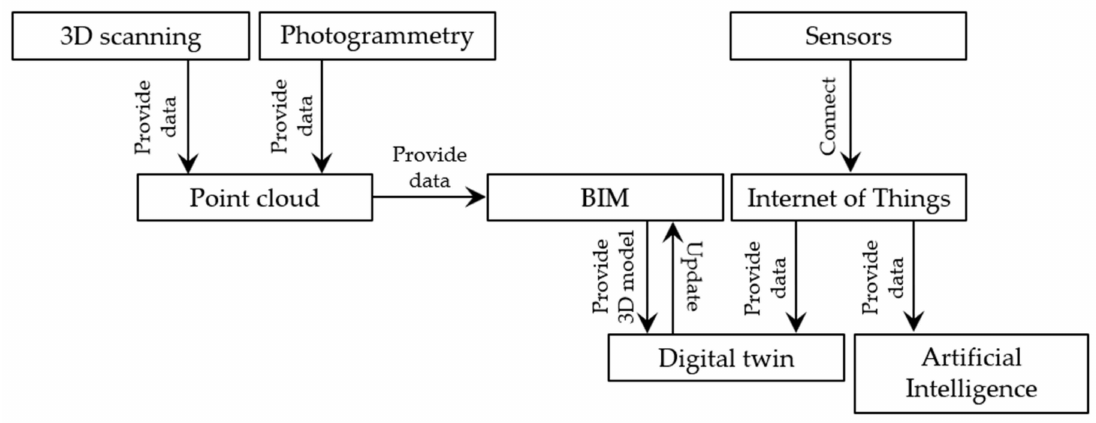
Figure 3. Interactions among new technologies for digital data acquisition and analysis in the built environment applied to the DBL. Source: adaptation from ‘Digitalisation in the construction sector. Analytical report’ [43]. Abbreviations: Building Information Modelling